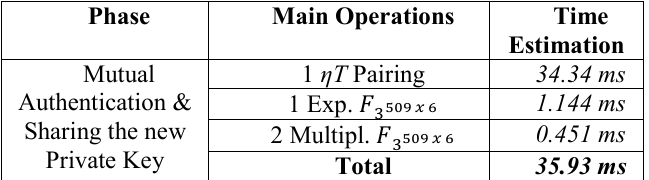
Table IV. Estimation of RFID-Tate at 208 MHz